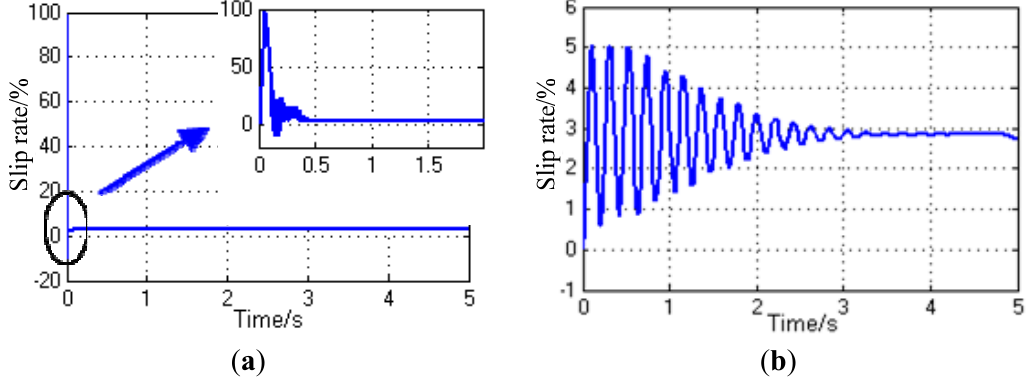
Figure 2. Comparison of two methods for tyre slip rate calculation: ( a ) Simulation results of Equation (6); ( b ) Simulation results of Equation (7).